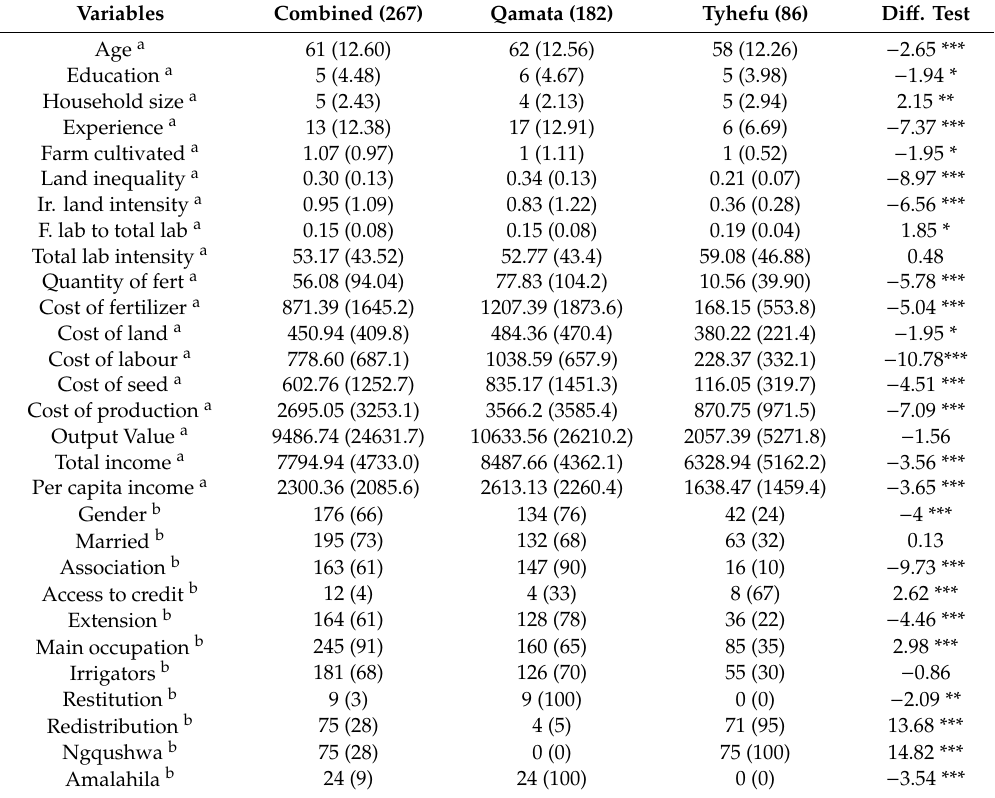
Table 2. Summary statistics of modelled